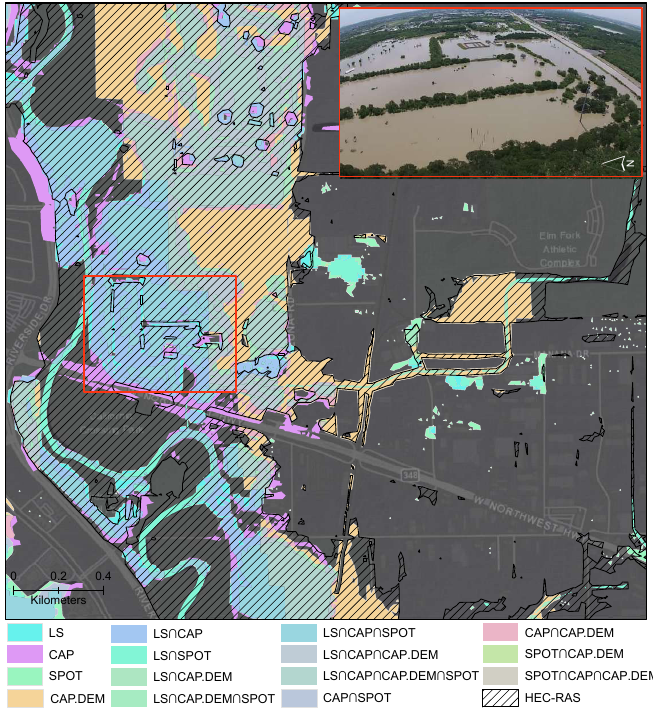
Figure 14. Flood inundation for 15 April 2015 estimated by MOP and